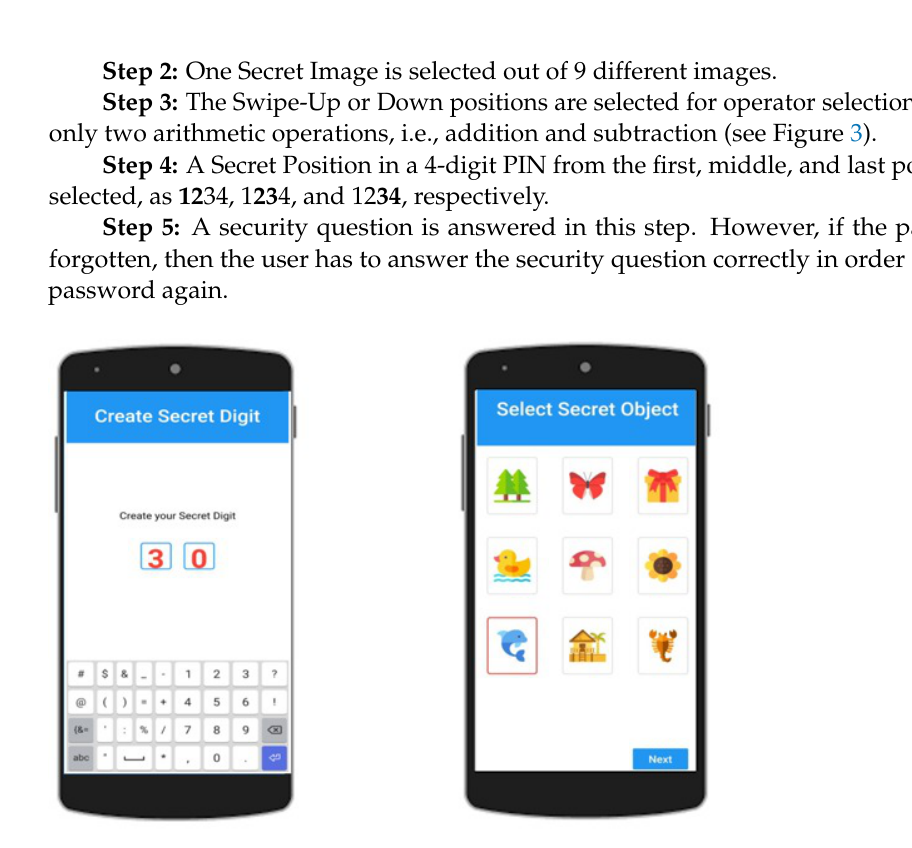
Figure 2. Select 2-digit secret number and one secret image.